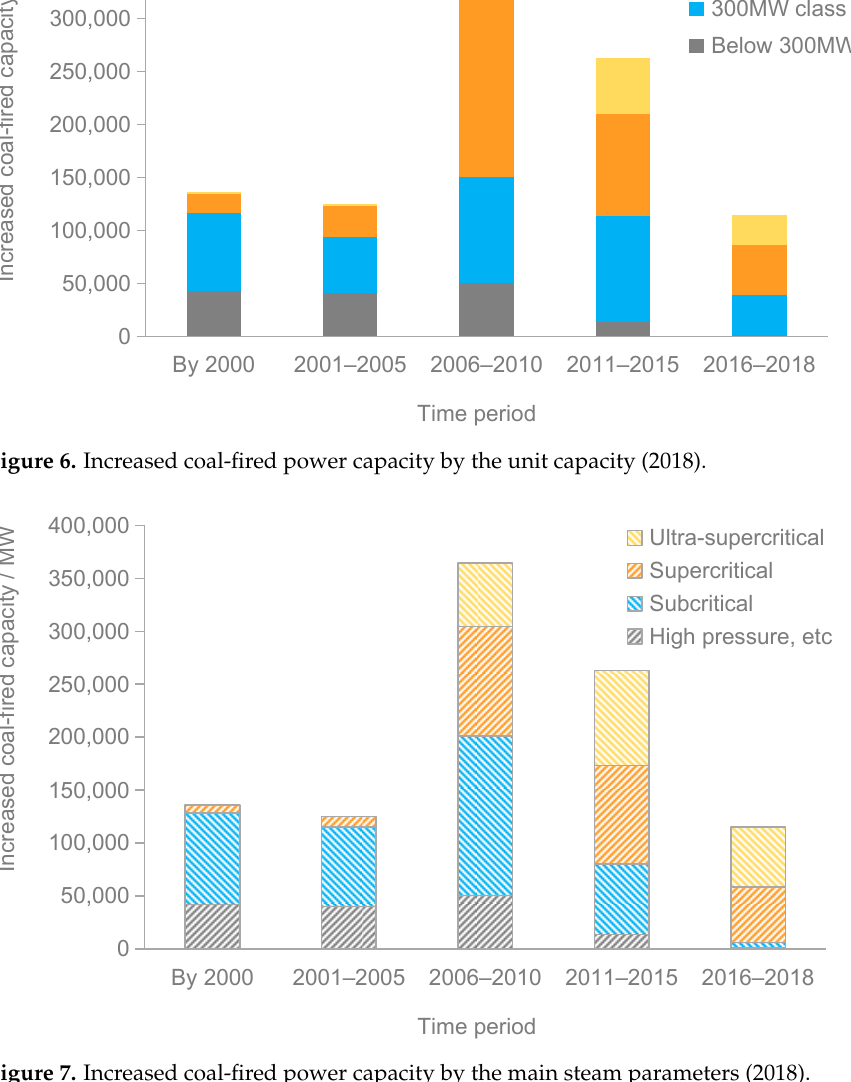
Figure 7. Increased coal-fired power capacity by the main steam parameters (2018).